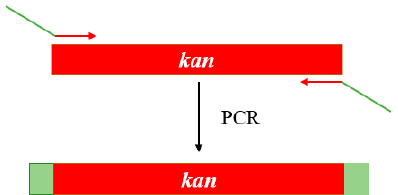
Figure 10. The construction of the kanamycin resistance gene cassette. Kan indicates the kanamycin resistance gene in red zones, while the green areas indicate the intergenic regions. The arrows indicate the locations of primers for PCR.